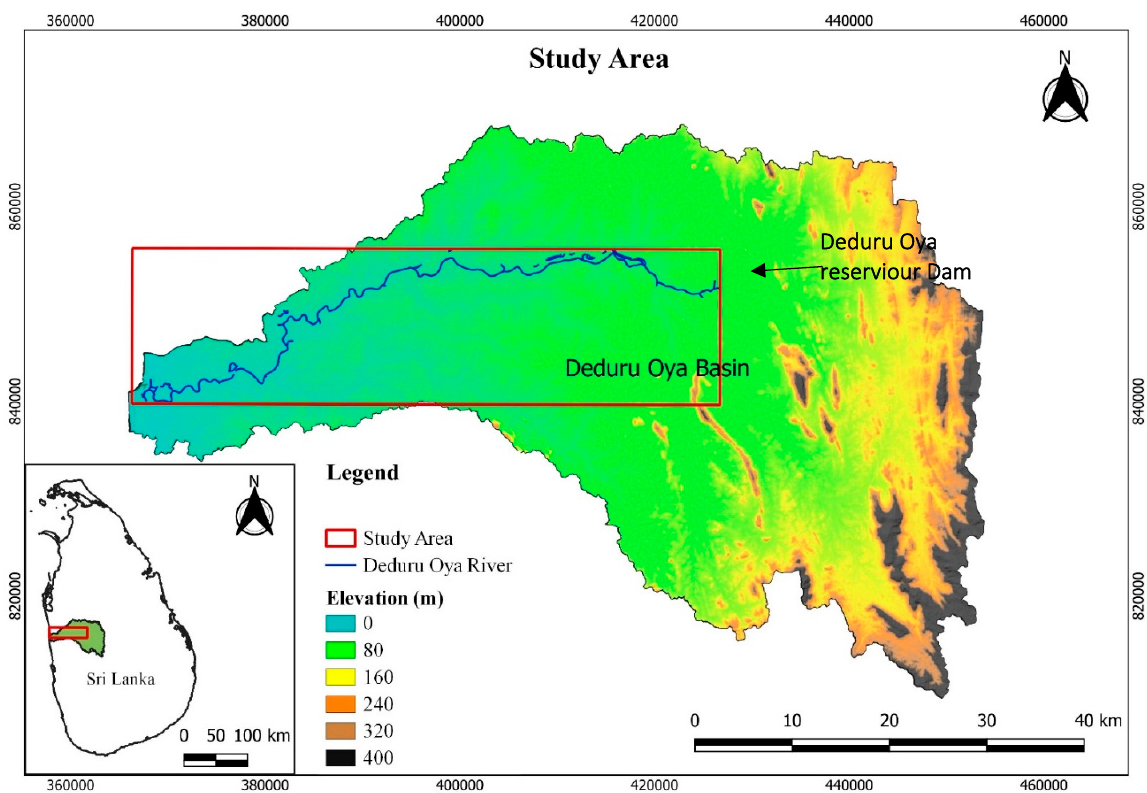
Figure 2. Map of the Deduru Oya river basin and the river segment selected for the analysis.